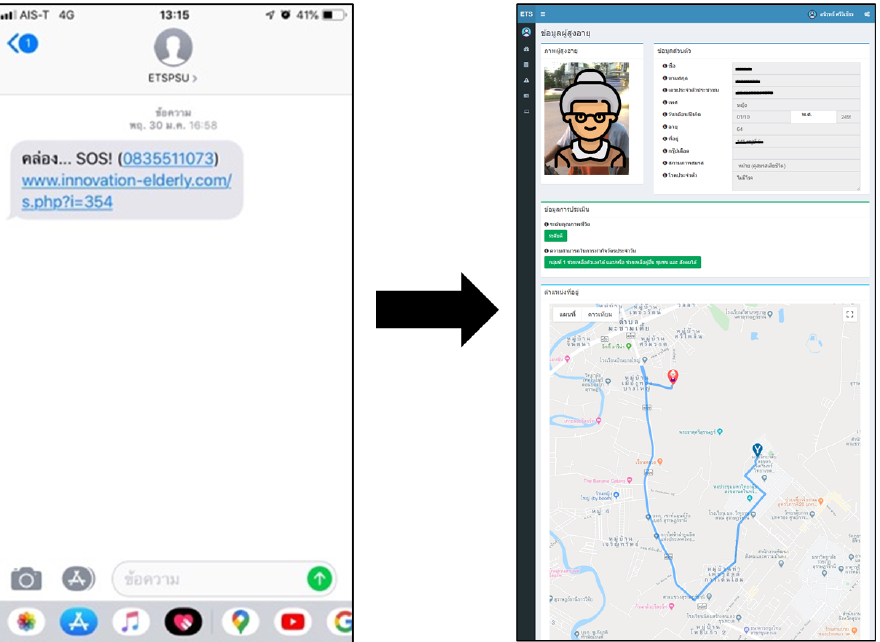
Figure 12. Example of the help